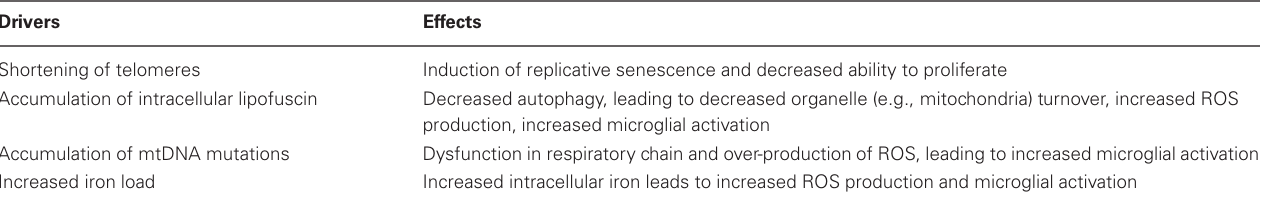
Table 2 | Summary of proposed drivers of microglial